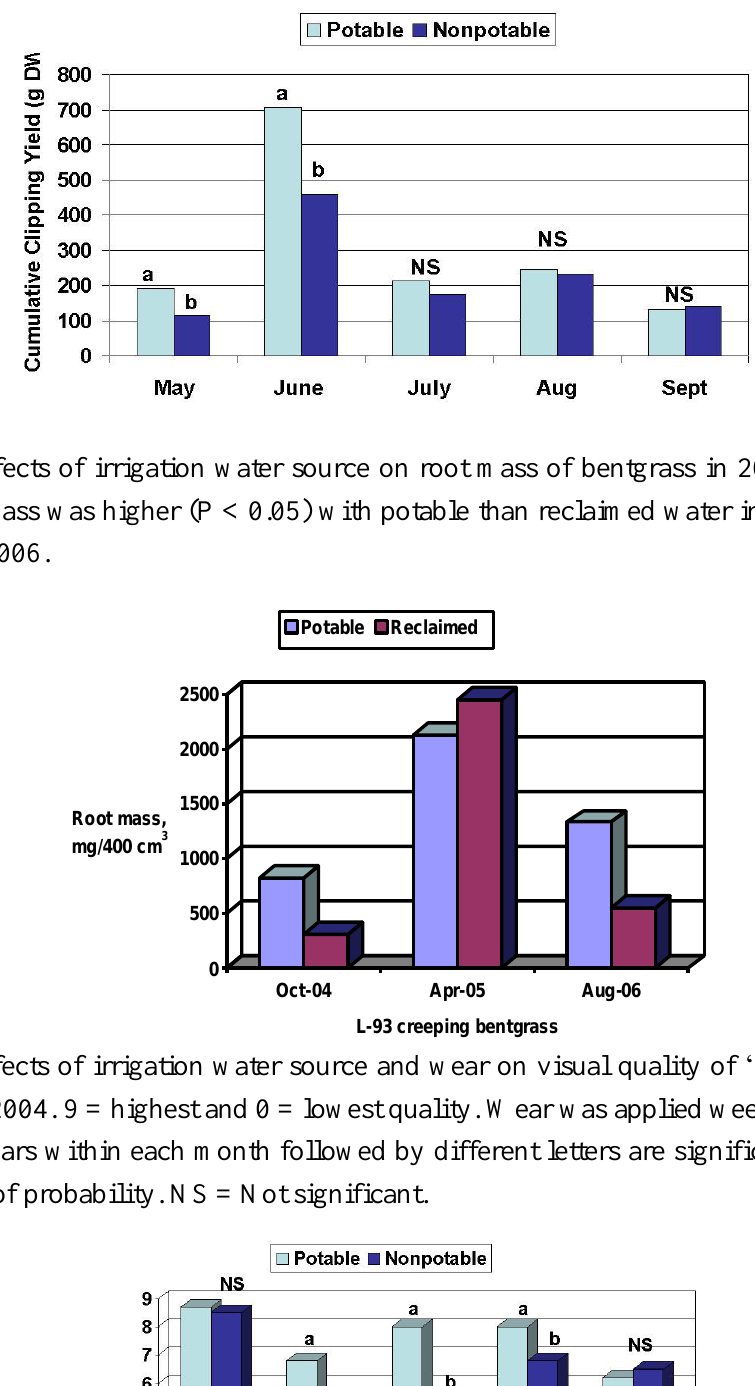
Figure 3. Effects of irrigation water source and wear on clipping yield of bermudagrass in 2005. Wear was applied weekly in May, July and September. Treatments by months with different letters are significantly different at 0.05 level of probability. NS = Not significant.